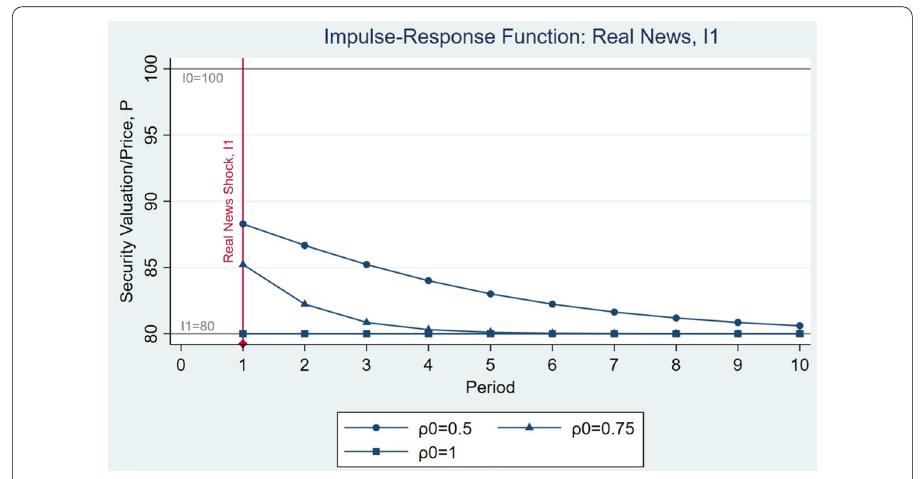
Fig. 1 Impulse-response function: real news,